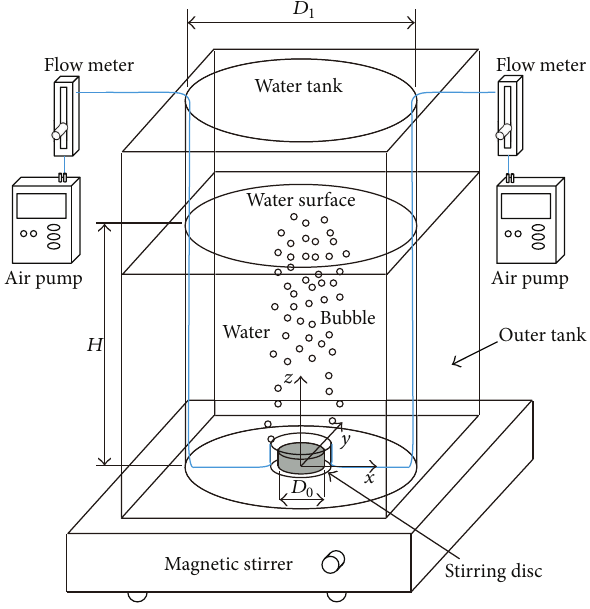
Figure 1: Experimental setup.